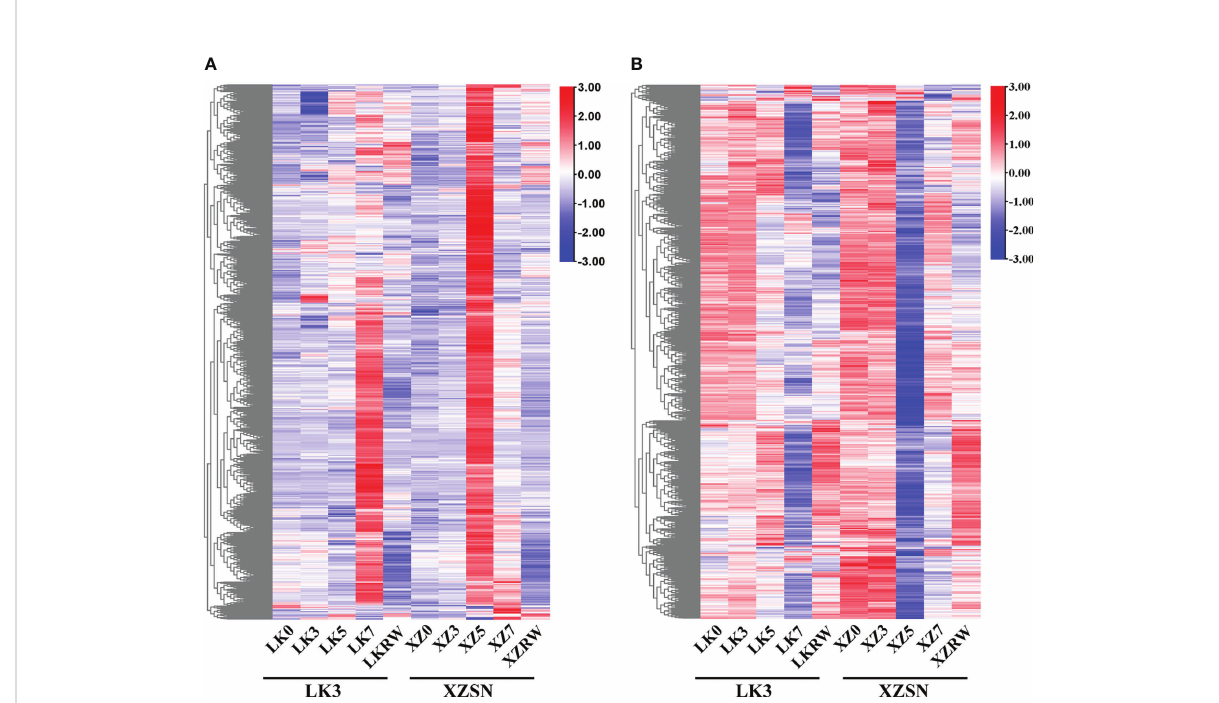
FIGURE 6 Heatmap of differentially expressed drought-responsive genes between XZSN and LK3. (A) Heatmap of upregulated drought-responsive genes in LK3 vs. XZSN. (B) Heatmap of downregulated drought-responsive genes in LK3 vs.